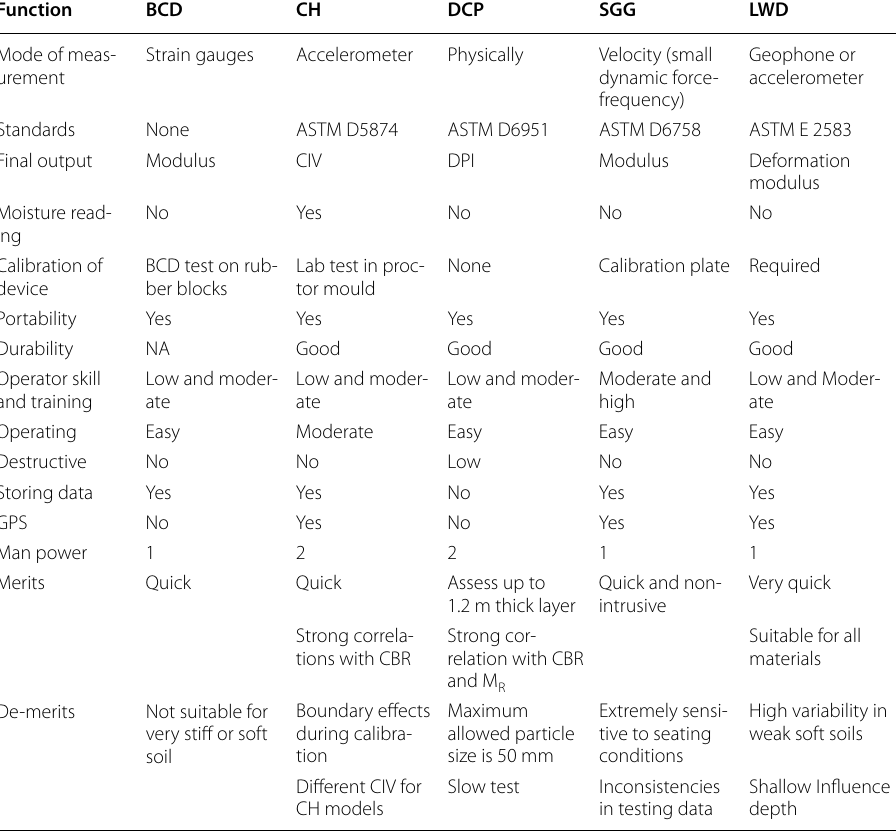
Table 2 Comparison of in-situ stiffness/modulus-based